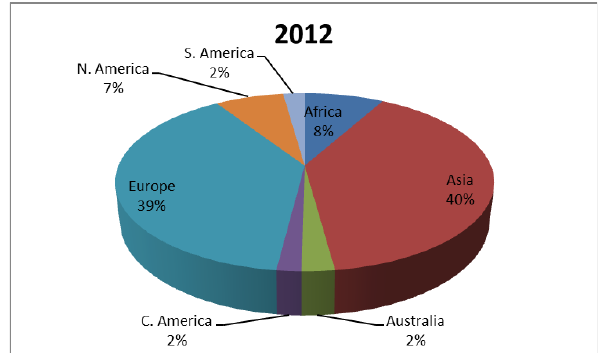
Table 1. Student Consortium membership growth.